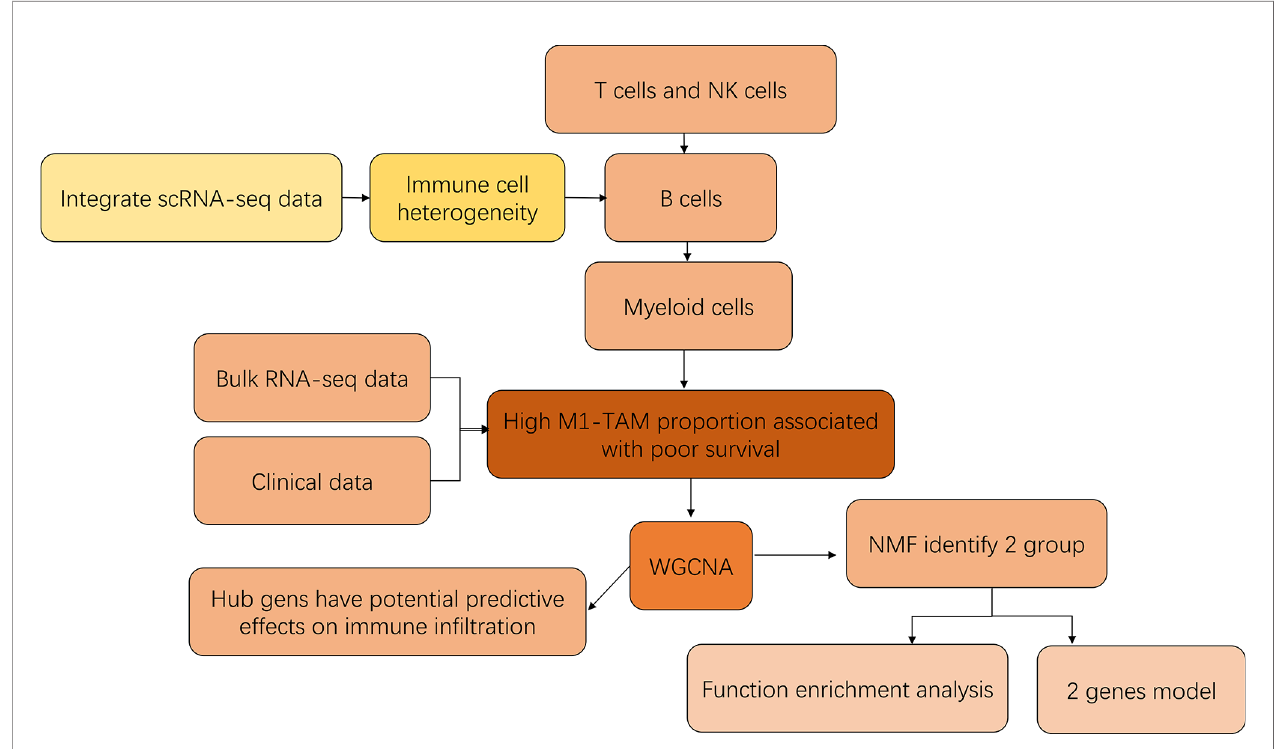
FIGURE 1 | The technical road map.